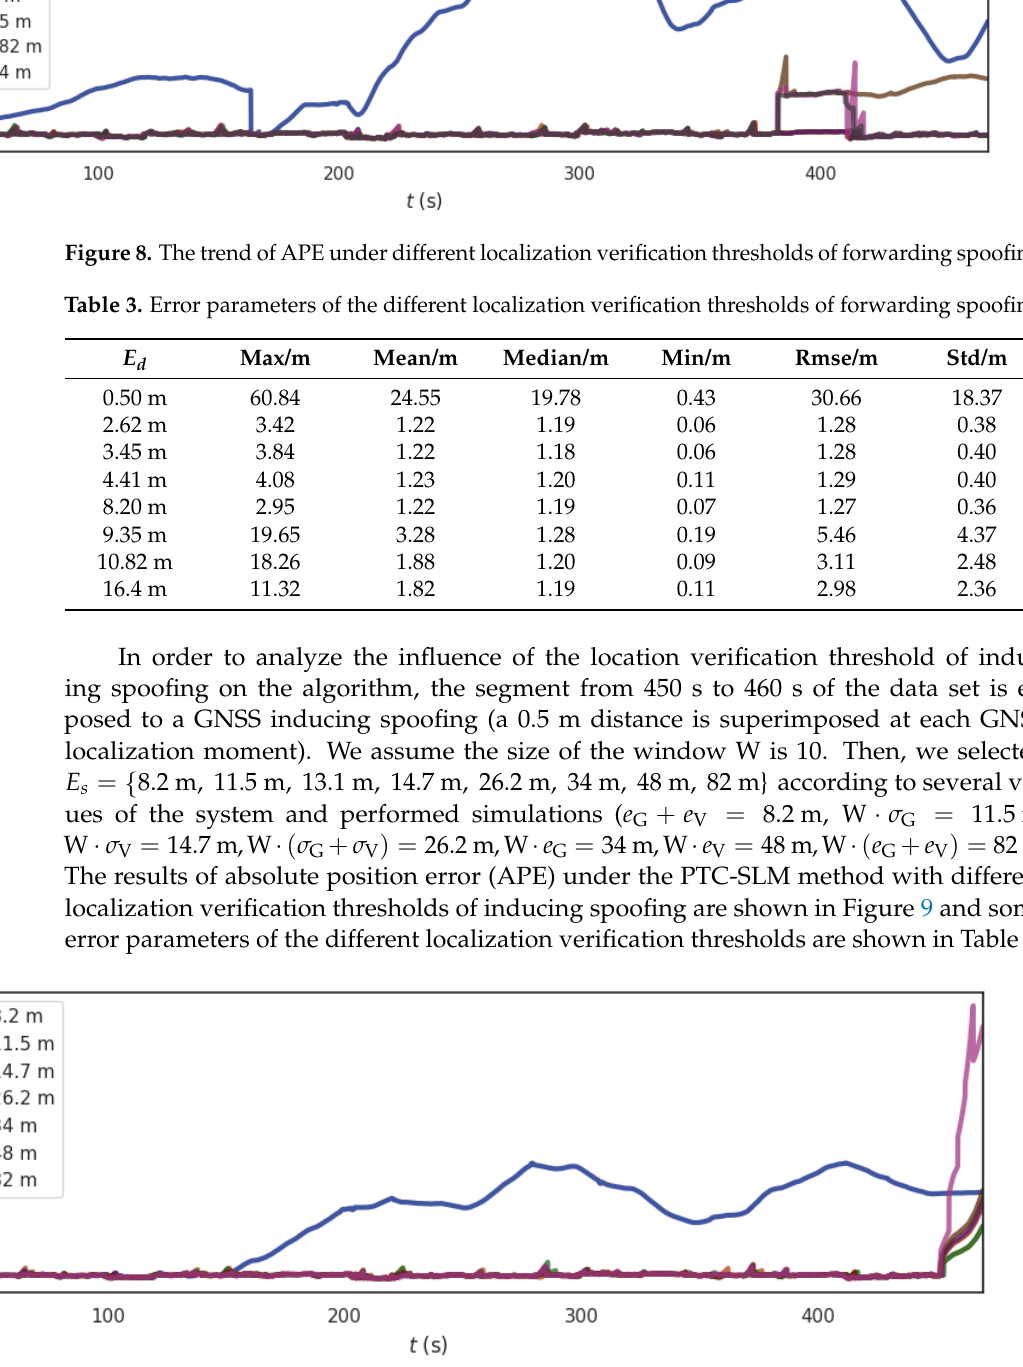
Table 4. Error parameters of the different localization verification thresholds of inducing spoofing.